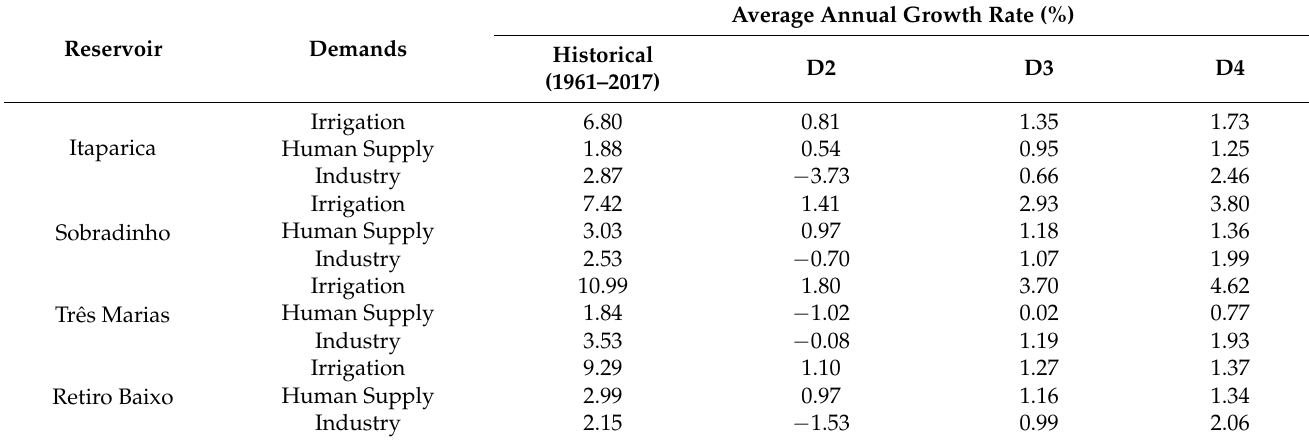
Table 6. Average annual growth rate of consumptive demands.